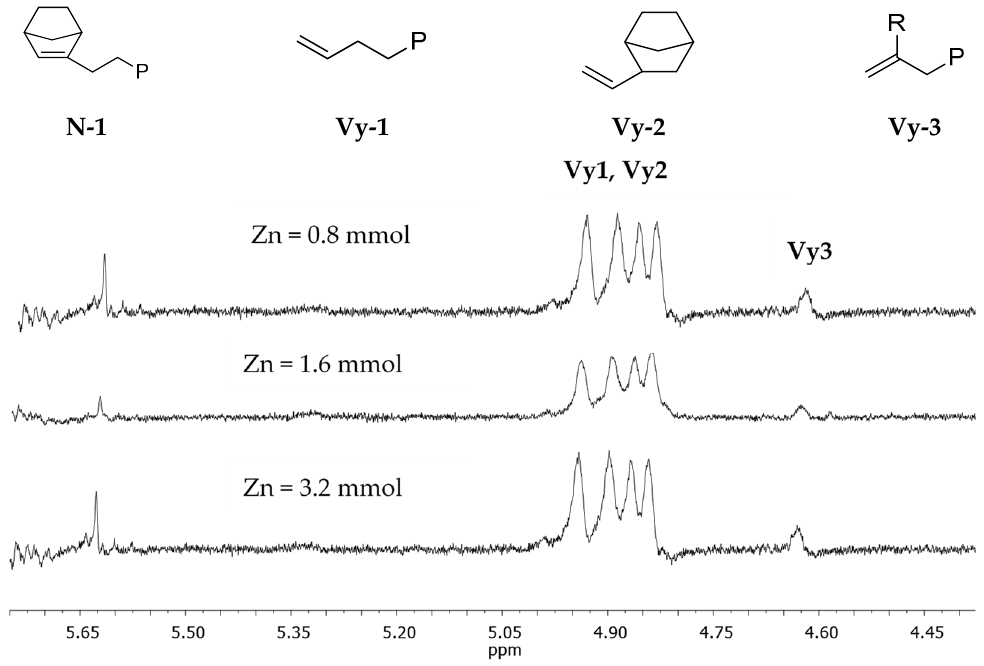
Figure 4. Expansions of the region between 4.4 and 5.75 ppm of 1 H NMR spectra (400 MHz, C 2 D 2 Cl 4 , (Table 1): ( top ) [Zn]/[Zr] = 55 (entry 1); ( middle ) [Zn]/[Zr] = 99 (entry 4); and ( bottom ) [Zn]/[Zr] = 198 (entry